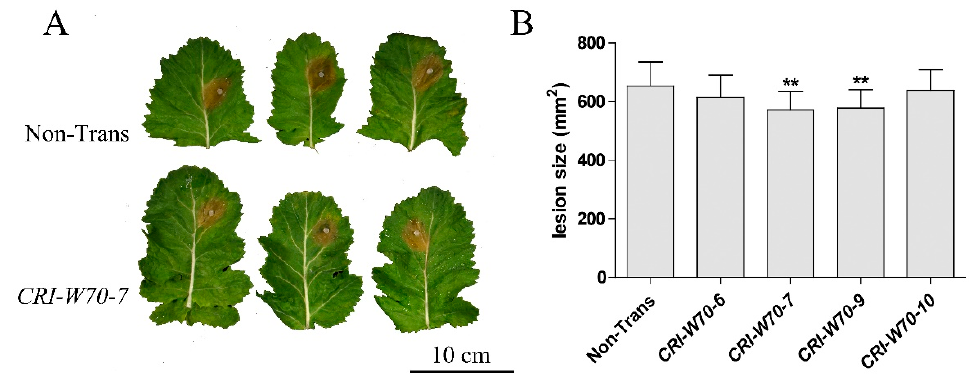
Figure 5. Lesion area on leaves of BnWRKY70 knockout B . napus lines inoculated with S . sclerotiorum . ( A ) Representatives of disease symptom on the Non-Transgenic (Non-Trans), BnWRKY70 knockout lines. Leaves of 6-week-old plants were inoculated with S . sclerotiorum . Photos were taken 48 h post-inoculation. ( B ) Lesion area on leaves of BnWRKY70 overexpression lines. ** indicate that the means are statistically different ( p < 0.01).